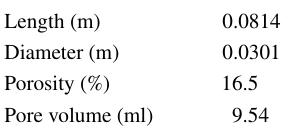
Table 2 The main core